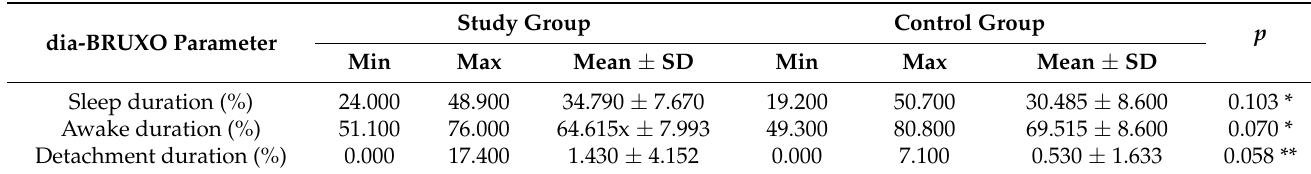
Table 2. Asleep and awake state duration and device detachment time.